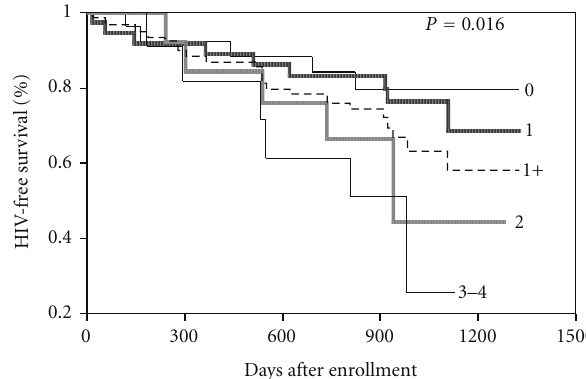
Figure 2: Kaplan-Meier HIV-free survival estimates for women with 0, 1, 2, 3-4, and at least 1 (1+) high-risk human papillomavirus